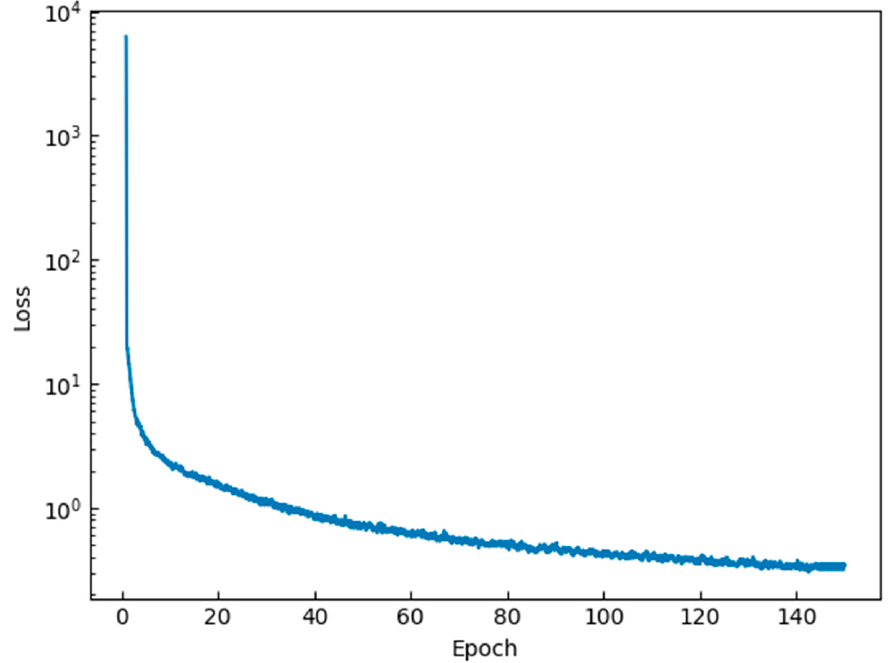
Figure 5. Loss curve for SuperDet.